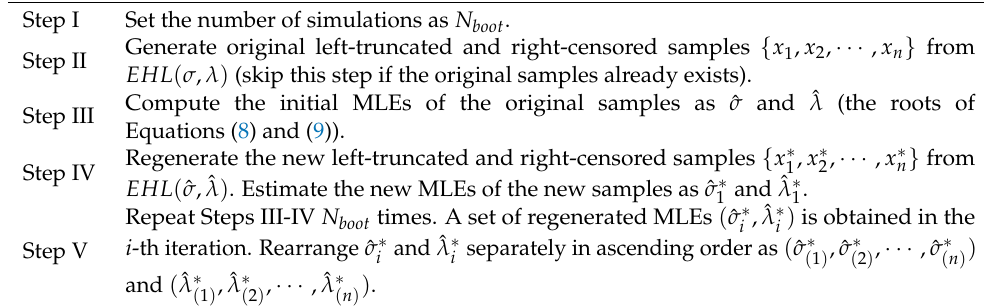
Algorithm 1 Establishing percentile bootstrap confidence intervals.